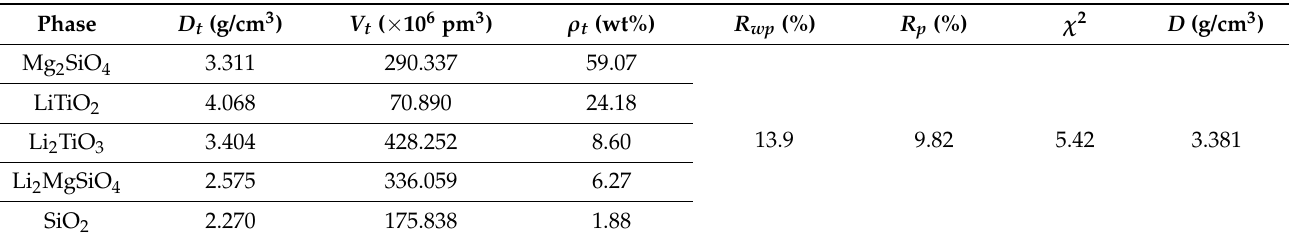
Table 1. Rietveld refinement result of the MLL ceramic.